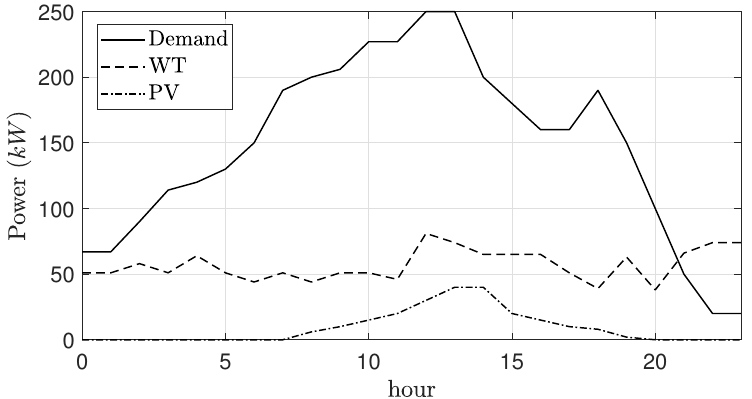
Figure 6. Power demanded and generated with renewable